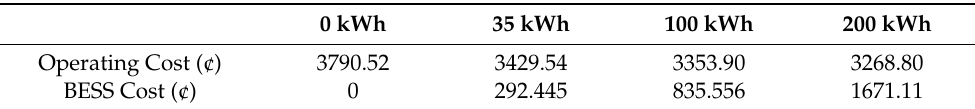
Table 2. Microgrid (MG) operating and battery energy storage system (BESS) costs according to BESS capacity.